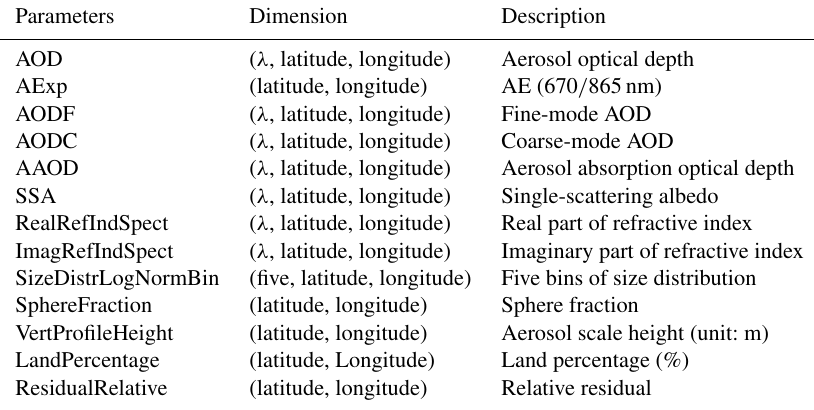
Table 1. List of aerosol parameters in PARASOL/GRASP products. Parameters Dimension Description AOD ( λ , latitude, longitude) Aerosol optical depth AExp (latitude, longitude) AE (670 / 865nm) AODF ( λ , latitude, longitude) Fine-mode AOD AODC ( λ , latitude, longitude) Coarse-mode AOD AAOD ( λ , latitude, longitude) Aerosol absorption optical depth SSA ( λ , latitude, longitude) Single-scattering albedo RealRefIndSpect ( λ , latitude, longitude) Real part of refractive index ImagRefIndSpect ( λ , latitude, longitude) Imaginary part of refractive index SizeDistrLogNormBin (five, latitude, longitude) Five bins of size distribution SphereFraction (latitude, longitude) Sphere fraction VertProfileHeight (latitude, longitude) Aerosol scale height (unit: m) LandPercentage (latitude, Longitude) Land percentage (%) ResidualRelative (latitude, longitude) Relative residual λ = 443 , 490 , 565 , 670 , 865 and